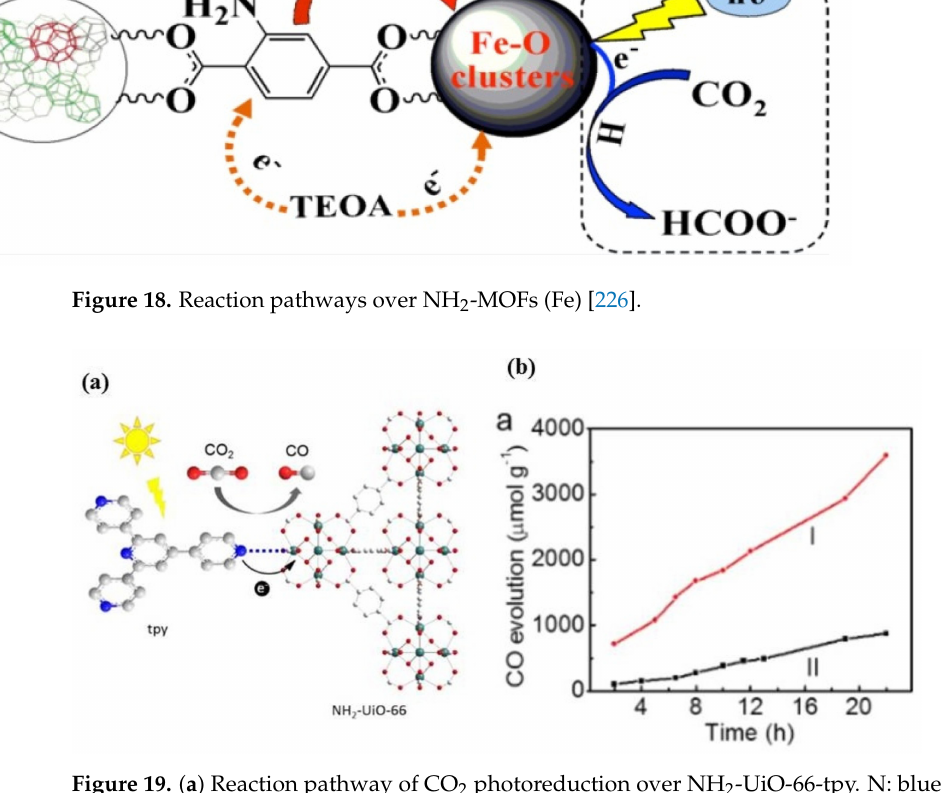
Figure 19. ( a ) Reaction pathway of CO 2 photoreduction over NH 2 -UiO-66-tpy. N: blue, O: red, Zr: indigo, C: light gray. ( b ) CO evolution over NH 2 -UiO-66-tpy (I) and NH 2 -UiO-66 (II) as a function of time